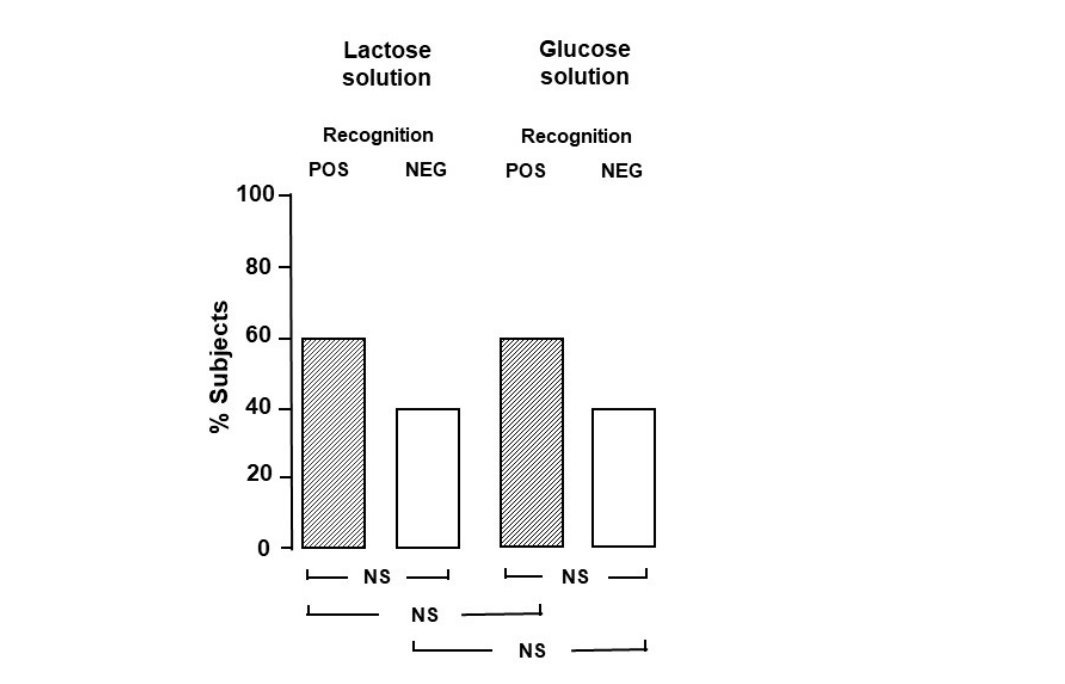
Figure 1. Recognition of lactose and glucose solutions used for blinded breath test in healthy volun- teers.